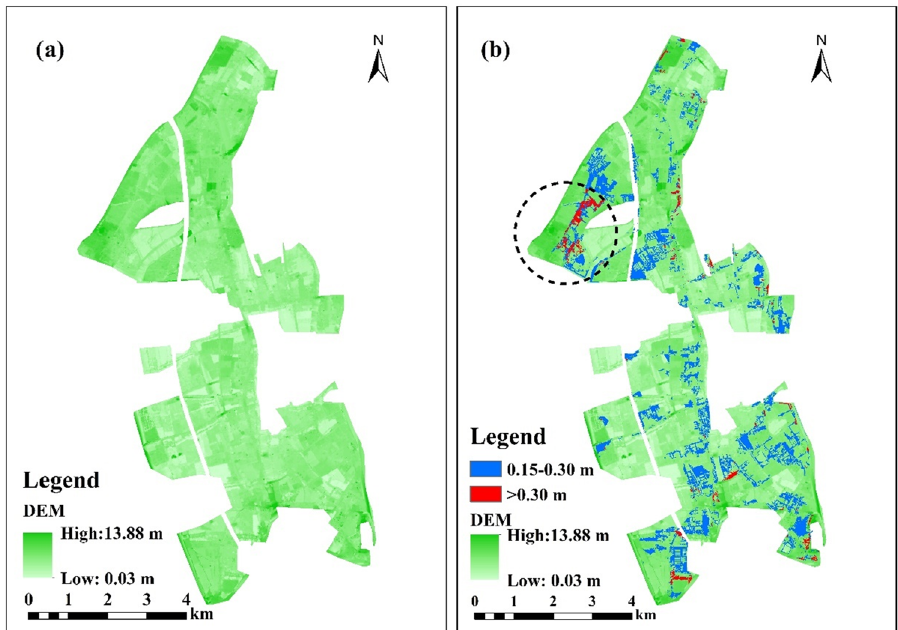
Figure 11. DEM and inundated areas of the case region: ( a ) DEM data; ( b ) inundated areas of the DEM image. This map was generated with ArcMap Version 10.0. (https:// www. esri. com/ en- us/ arcgis/ produ cts/ arcgis- deskt op/ overv iew).